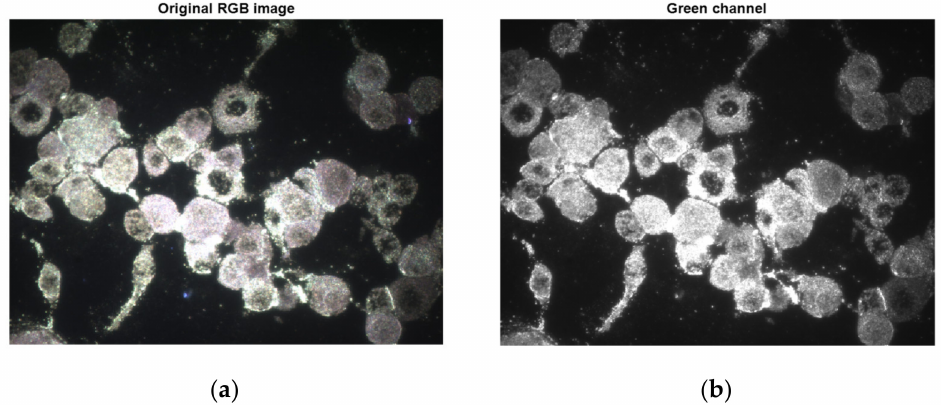
Figure 7. Green channel extraction: ( a ) original RGB image; ( b ) green channel.